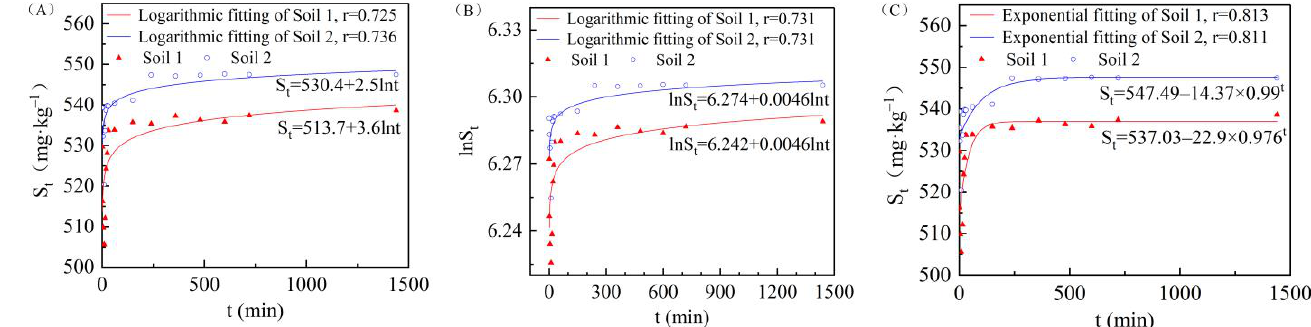
Figure 6. Elvoich equation fitting ( A ), biconstant equation fitting ( B ), and similar exponential asymptote equation fitting ( C ) for cadmium adsorption in the two soil types.